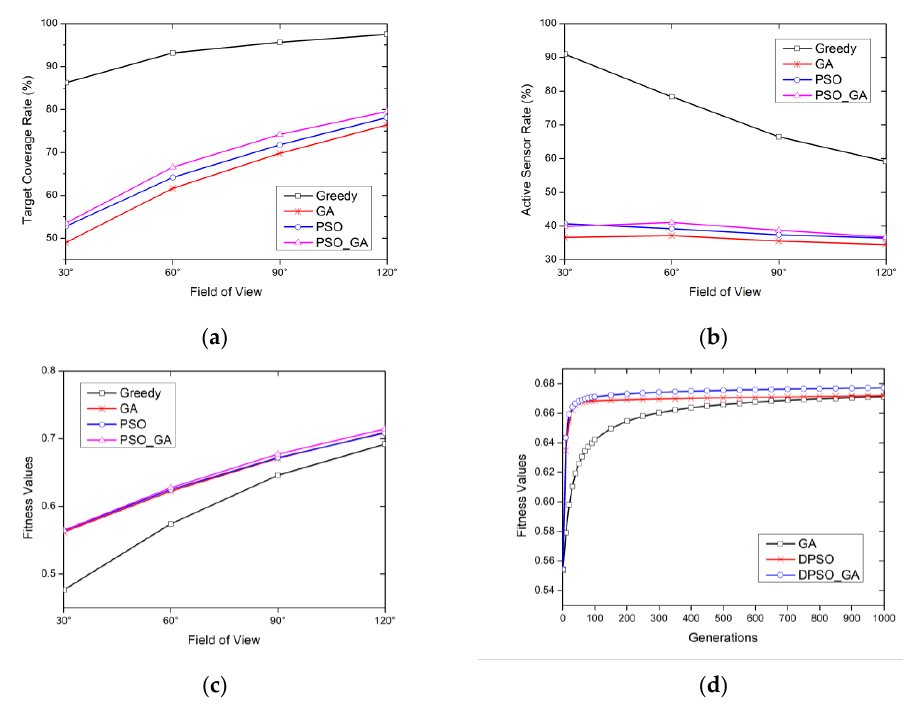
Figure 6. Effect of the field of view on the target coverage rate, active sensor rate, and fitness values in greedy, GA, DPSO, and DPSO_GA algorithms. ( a ) Target coverage rate, ( b ) active sensor rate, ( c ) fitness values, and ( d ) fitness values versus number of generations for the GA, DPSO, and DPSO_GA algorithms.